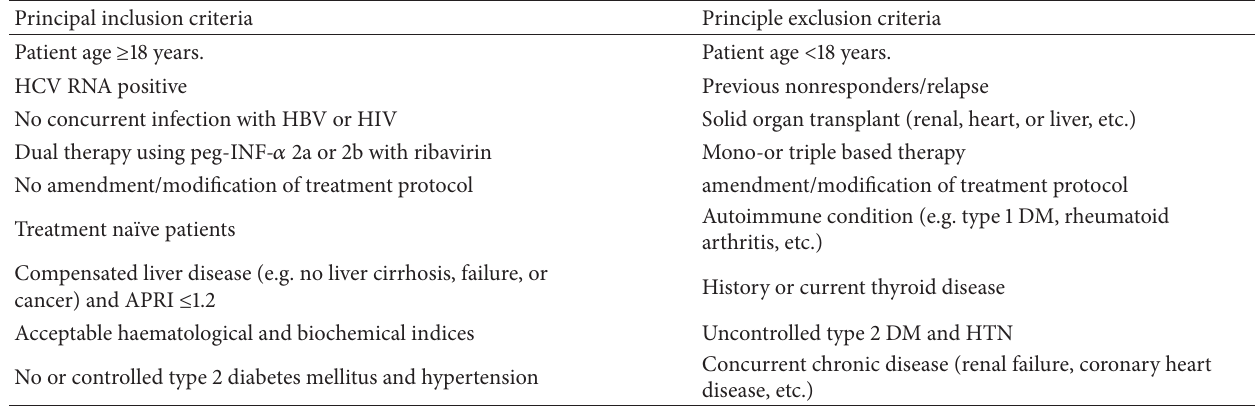
Table 1: Inclusion and exclusion